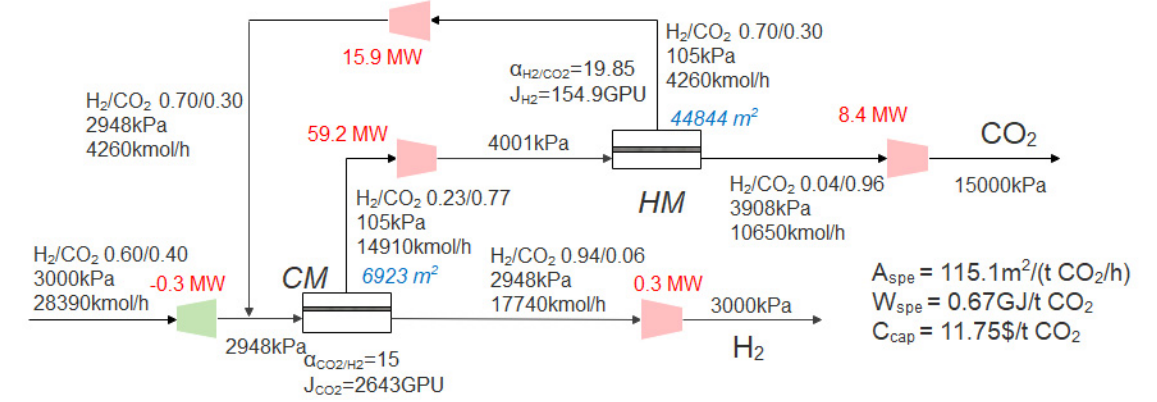
Figure 12. The optimal process when the performance of the H 2 -selective membrane and CO 2 -selective membrane changes based on the Robeson upper bound. Table 6. Information of the optimal process of increasing CO 2 recovery when the H 2 -selective and CO 2 -selective membranes change based on the Robeson upper bound.